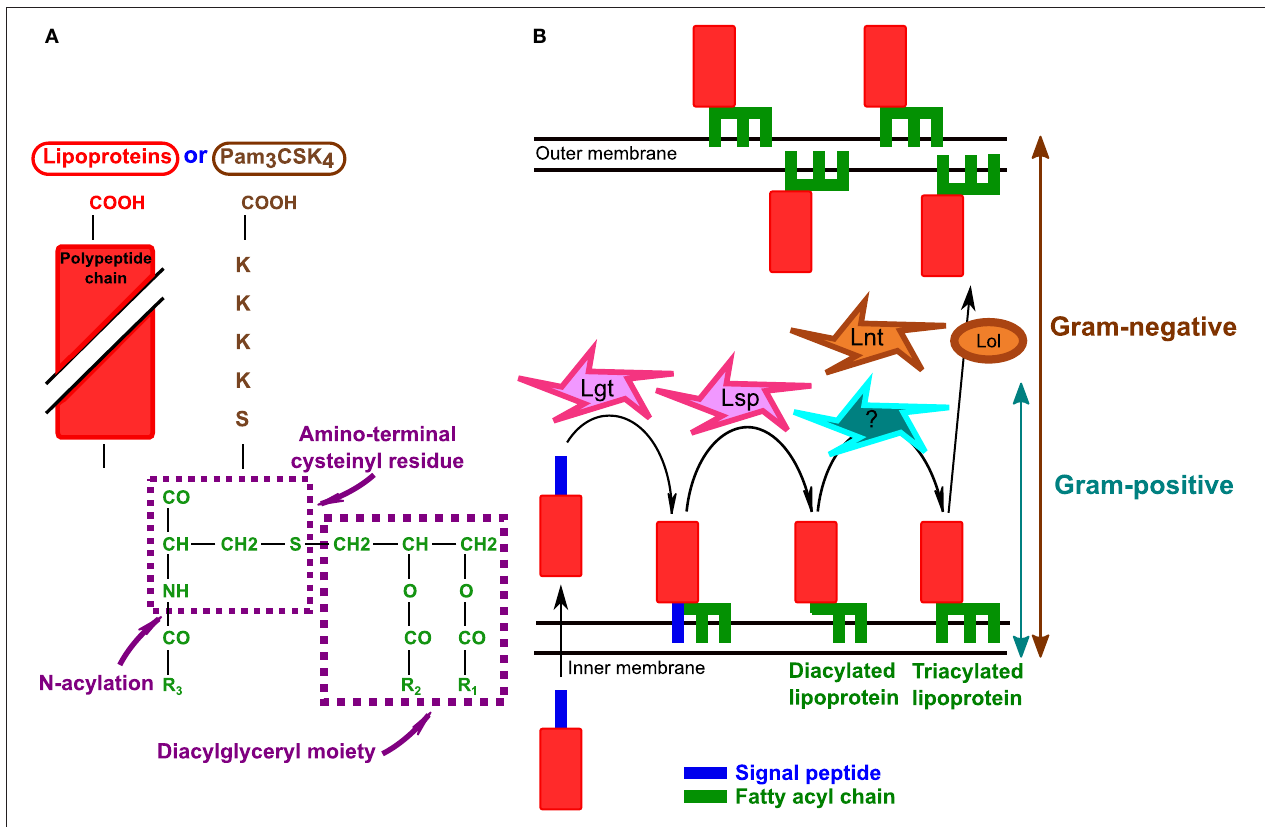
FIGURE 1 | Bacterial lipoproteins. (A) Structure of bacterial lipoproteins according to Braun and Wu (1994). The structure of synthetic lipopeptide Pam 3 CSK 4 is also indicated. Triacylated bacterial lipoproteins and Pam 3 CSK 4 have the same lipid moiety (green). R 1 , R 2 , and R 3 are fatty acyl chains. Adapted from Braun and Wu (1994) and Chambaud et al. (1999). (B) Biosynthesis of lipoproteins in Gram-negative and Gram-positive bacteria. After crossing the cytoplasmic membrane Lgt (prolipoprotein diacylglyceryl transferase) transfers a diacylglyceride to